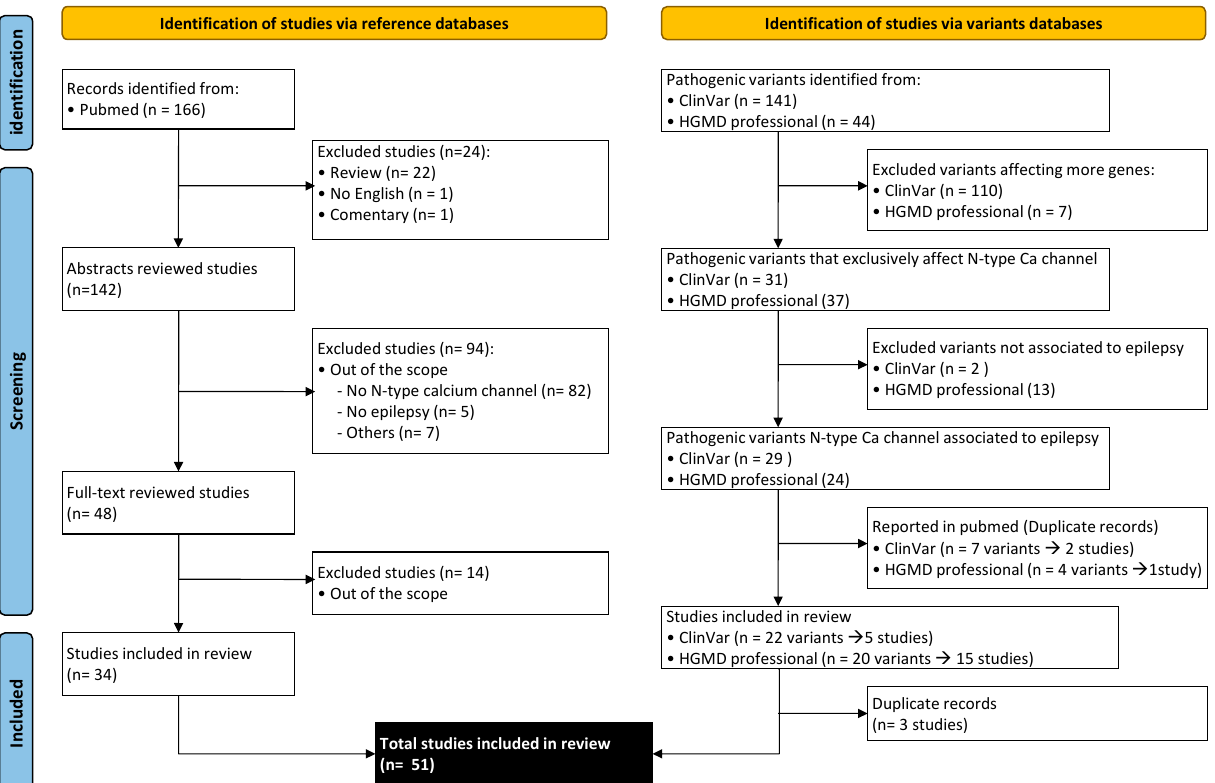
Figure 2. Flow diagram summarizing the identi fi cation, screening, and studies selection from PubMed, ClinVar, and HGMD professional base on PRISMA 2020 fl ow diagram template [23].